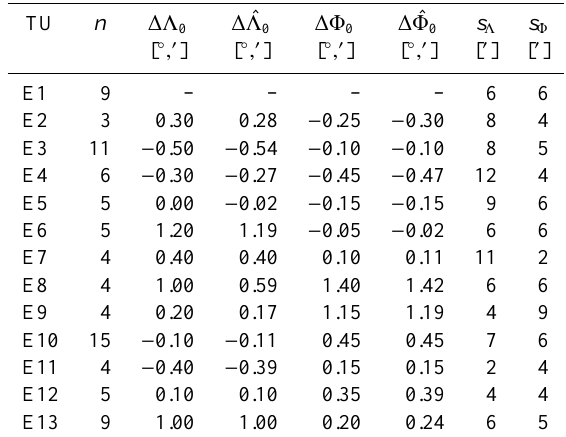
Table 3. Simulated example: transformation units (TU); number of places n ; given relative shifts ∆Λ 0 , ∆Φ 0 and determined relative shifts ∆ ˆ Λ 0 , ∆ ˆ Φ 0 with respect to E1; determined ancient coordinate accuracies s Λ , s Φ